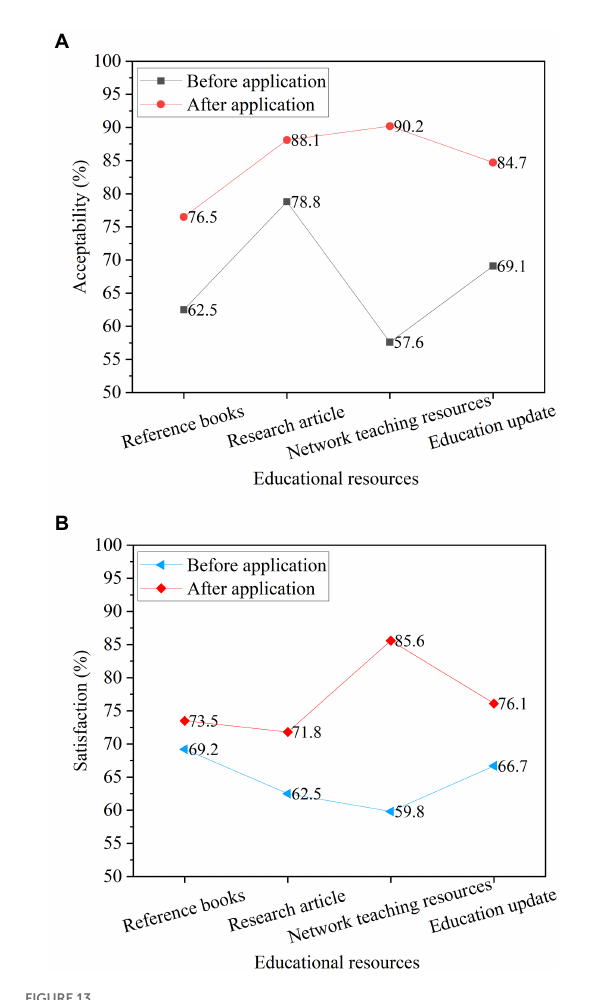
FIGURE 13 Satisfaction of teaching resource query results. (A) Comparison of acceptance of teaching resource query results; (B) Satisfaction comparison of teaching resource query efficiency.